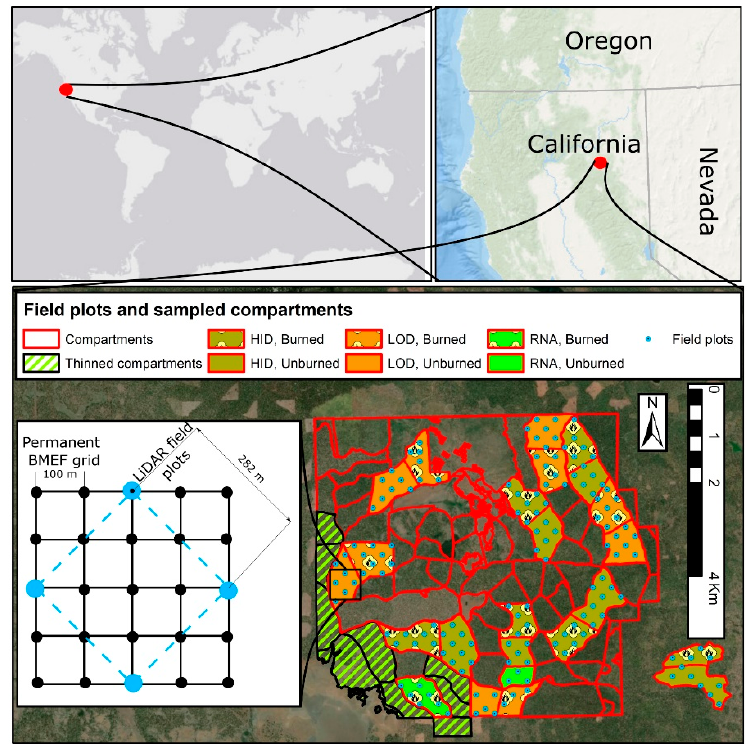
Figure 1. Study area location map, delineated stands and field plots, and detailed diagram showing the light detection and ranging LiDAR field plots grid over the permanent Blacks Mountains Experimental Forest (BMEF) grid of permanent makers.